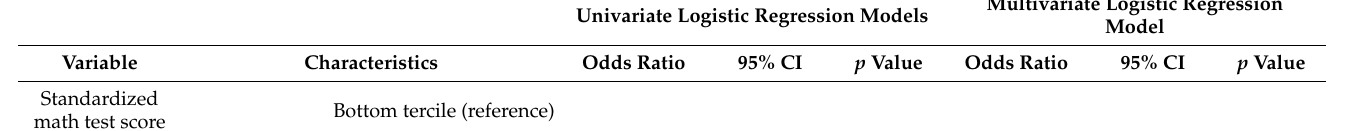
Multivariate Logistic Regression